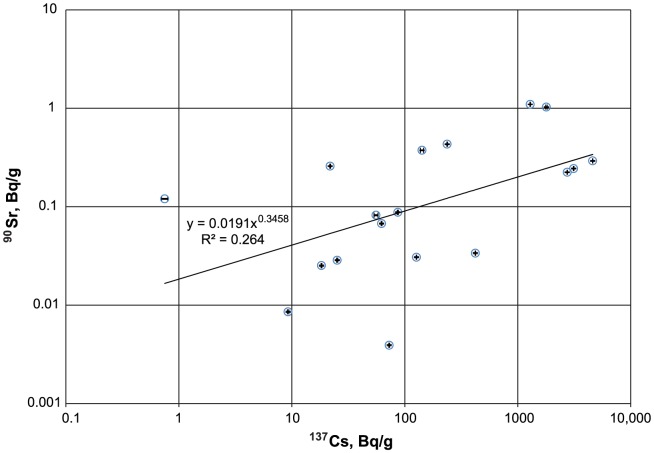
Correlation of the activity concentrations of 90Sr vs. 137Cs.Error bars are due to counting statistics. Activities were decay corrected to the time of the accident. Please note the logarithmic scales.